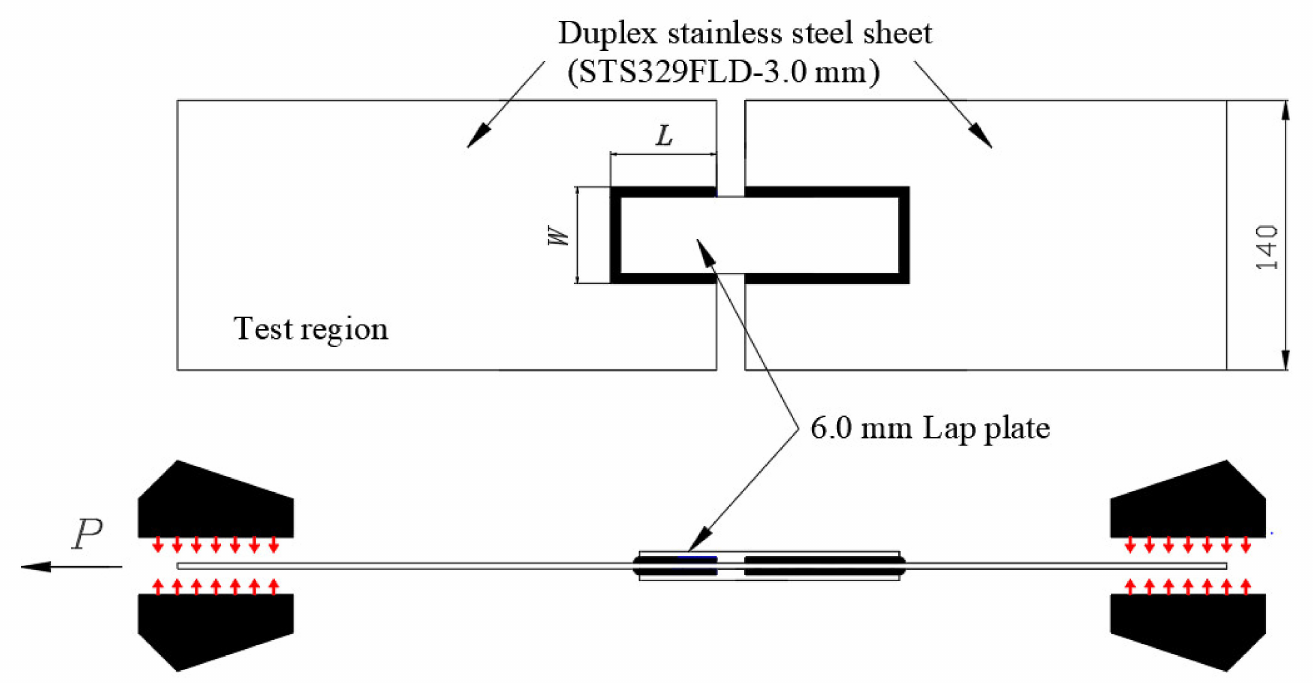
Figure 2. Schematic plot of double-lap fillet welded connection